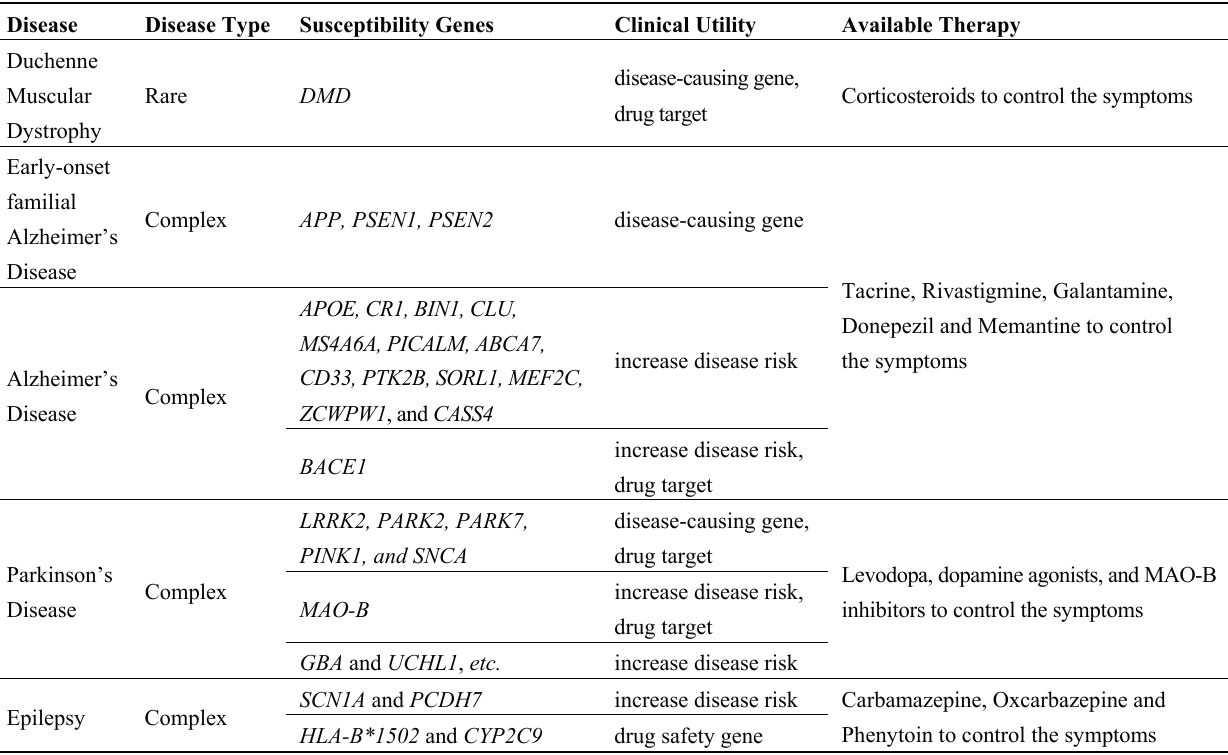
Table 1. Case example